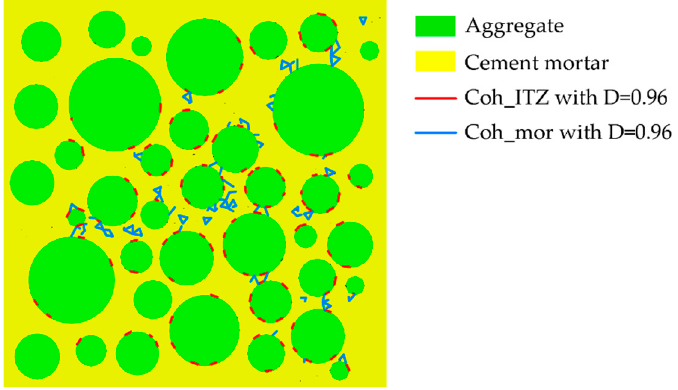
Figure 9. The distribution of the CIEs with D = 0.98 when σ / σ max ≈ 0.77 ( ε > ε p ).